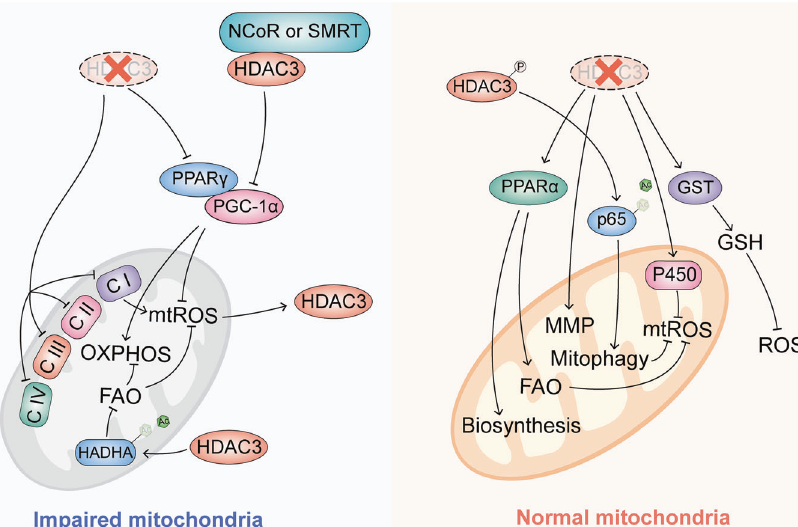
Fig. 3 HDAC3 regulate mitochondrial metabolism and function. The role of HDAC3 in mitochondria and regulation of mtROS is complex and fraught with contradictions. HDAC3 can both impair and protect mitochondria through regulating different signaling pathways, mtROS, FAO, OXPHOS, and